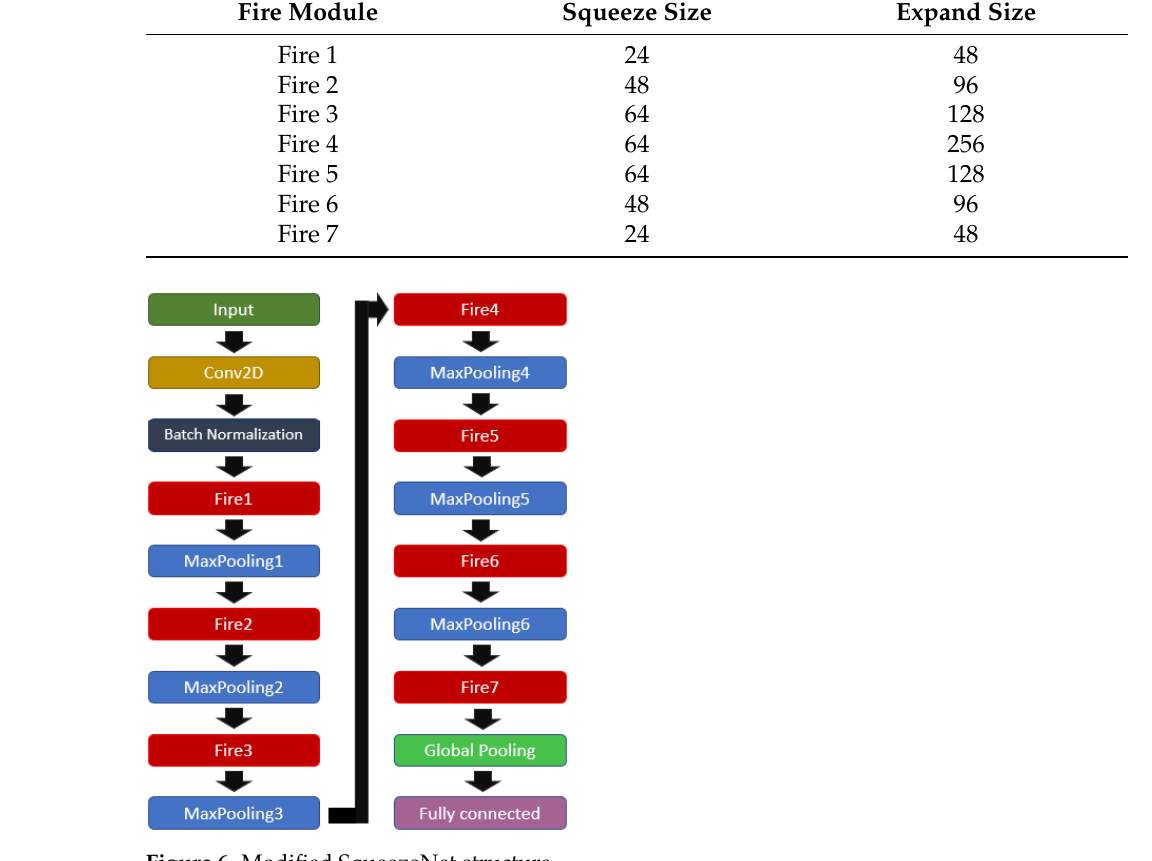
Figure 6. Modified SqueezeNet structure.